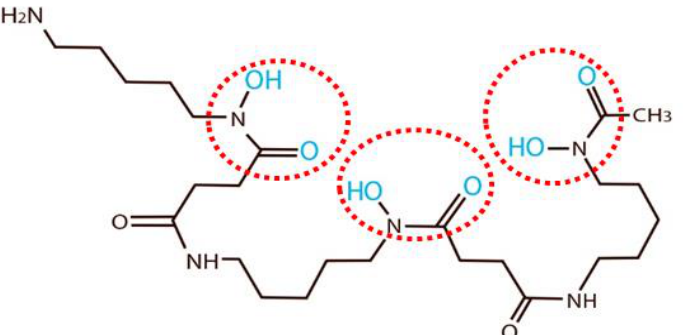
Figure 2. Chemical structure of DFO-B with the functional groups that donate the electron pairs to a metal ion (highlighted in cyan) and the hydroxamate chemical groups that participate in the siderophore’s molecule (circled in red).